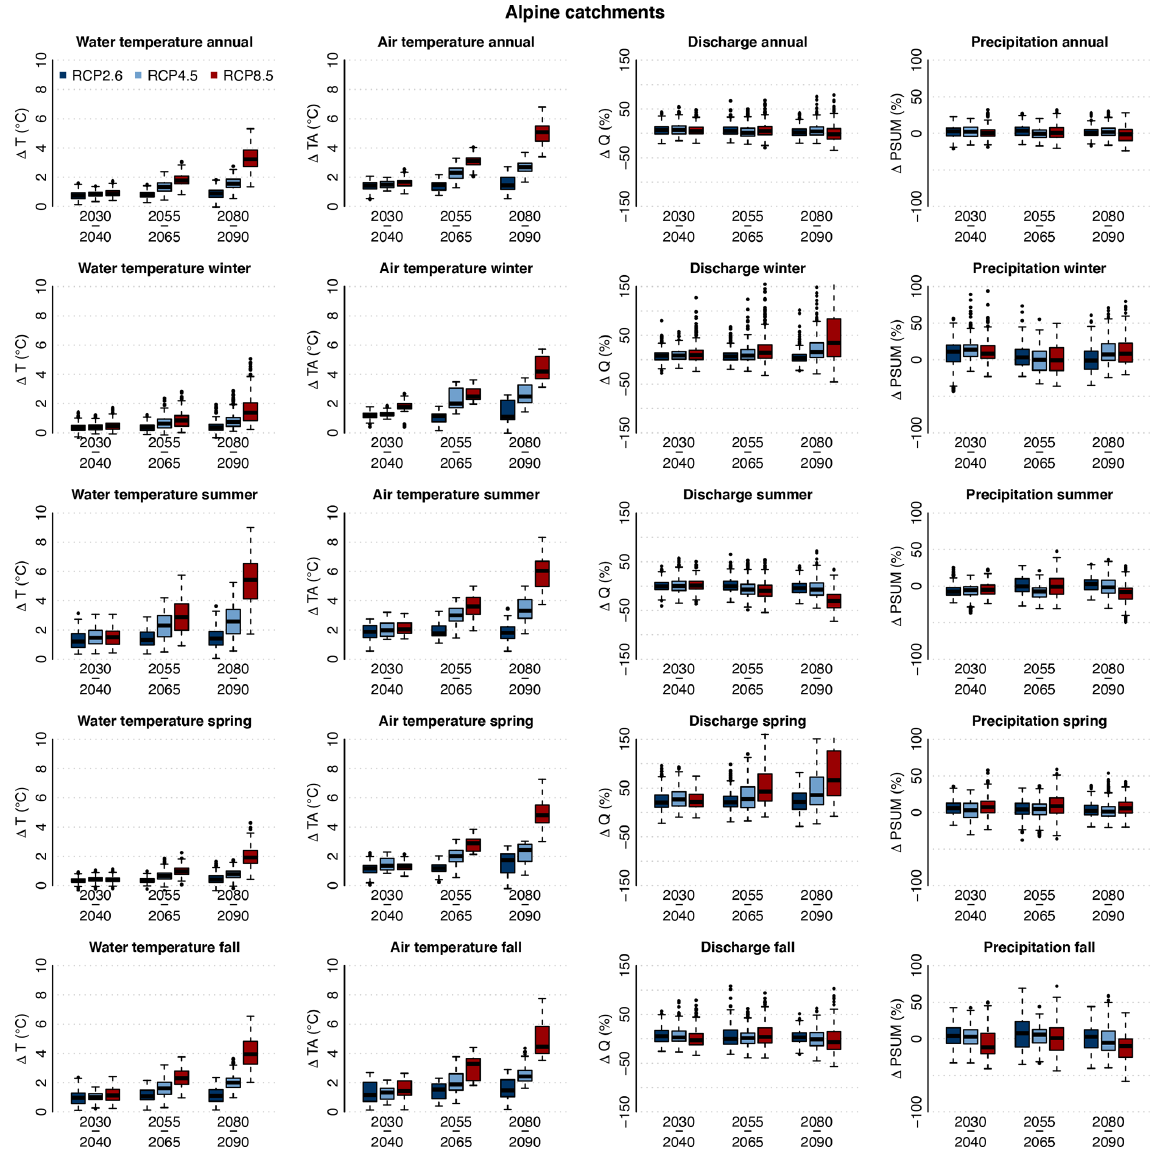
Figure 5. Changes in river temperature ( (cid:49)T ), air temperature ( (cid:49) TA), discharge ( (cid:49)Q ), and precipitation ( (cid:49) PSUM), from left to right column, over the periods 2030–2040, 2055–2065, and 2080–2090 and for the three RCPs compared to the reference period 1990–2000, averaged over all considered Alpine catchments. Row 1 shows the annual change, row 2 the winter seasonal change, row 3 the summer seasonal change, row 4 the spring seasonal change, and row 5 the autumn seasonal